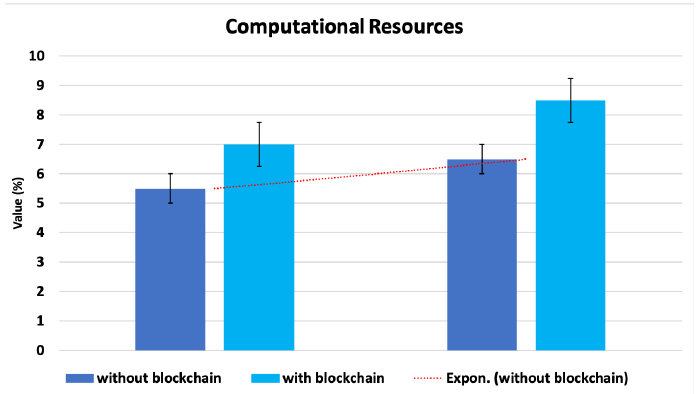
Figure 13. Complexity of the proposed architecture’s